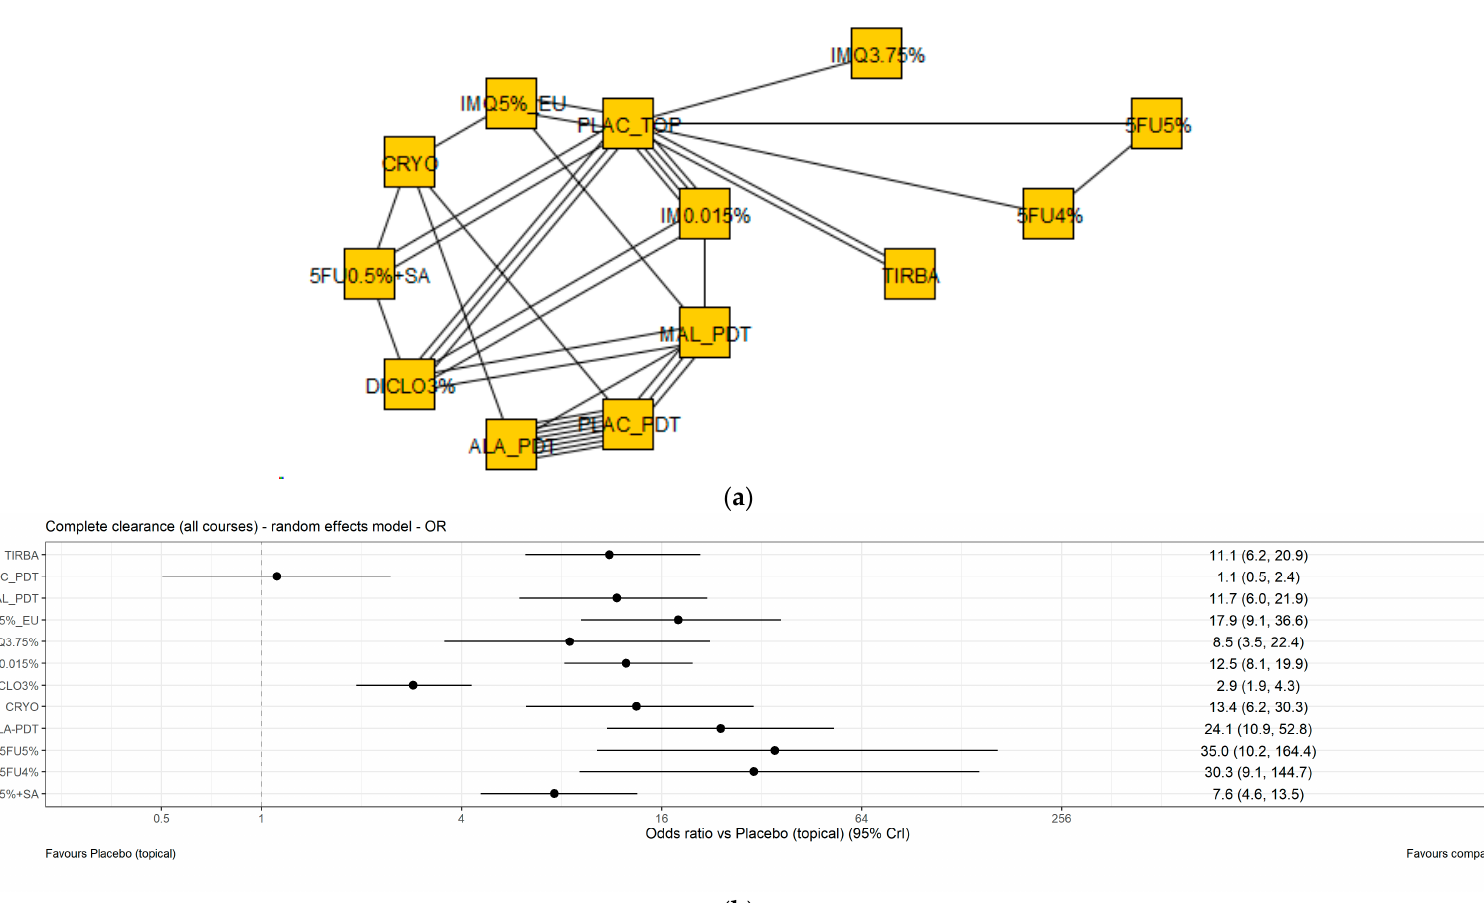
Figure 3. Complete clearance, European base case analysis—network diagram and forest plot. ( a ) Network diagram. ( b ) Forest plot of the interventions from the main network showing odds ratios against placebo with 95% credible intervals. 5FU0.5% + SA—5 fluorouracil 0.5% + salicylic acid 10%; 5FU4%—5 fluorouracil 4%; 5FU5%—5 fluorouracil 5%; ALA_PDT—Photodynamic therapy with 5-Aminolevulinic acid sensitizer; CRYO—Cryotherapy; DICLO3%—Diclofenac 3%; IM0.015%—Ingenol mebutate 0.015%; IMQ3.75%—Imiquimod 3.75%; IMQ5%_EU—Imiquimod 5% EU posology; MAL_PDT—Photodynamic therapy with